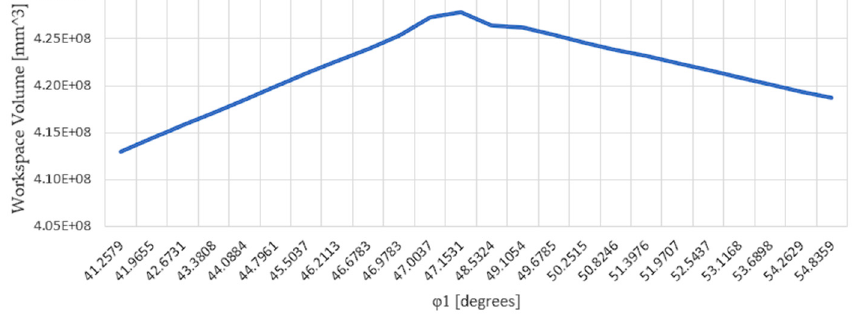
Figure 10. Graphical representation of the workspace volume optimization results from CATIA V5.